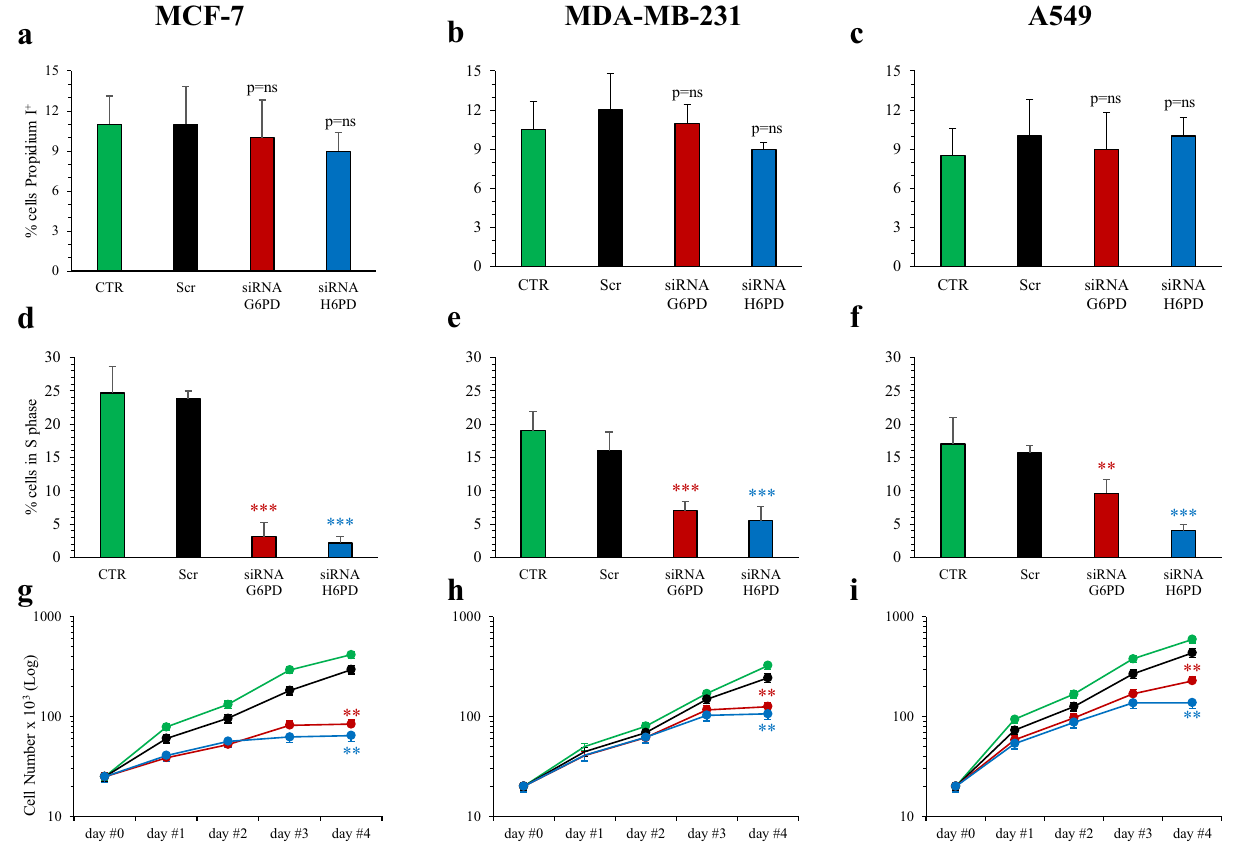
Figure 2. Effect of G6PD and H6PD silencing on culture growth. Percent of Propidium iodide positive dead cells in MCF-7 ( a ), MDA-MB-231 ( b ) and A549 ( c ) cultured under control condition (CTR, green), scramble siRNA (Scr, black), siRNA G6PD (red) and siRNA H6PD (blue). Either G6PD or H6PD silencing did not affect the number of dead cells. Percent of cells in S phase in MCF-7 ( d ), MDA-MB-231 ( e ) and A549 ( f ). Silencing of either G6PD or H6PD caused a marked reduction in the number of actively DNA synthetizing cells. Panels ( g – i ) display the time course of culture growth: silencing of either enzyme cause a progressive deceleration of cell proliferation that eventually reached a flat phase after 72 h. **p < 0.01, ***p < 0.001 vs corresponding